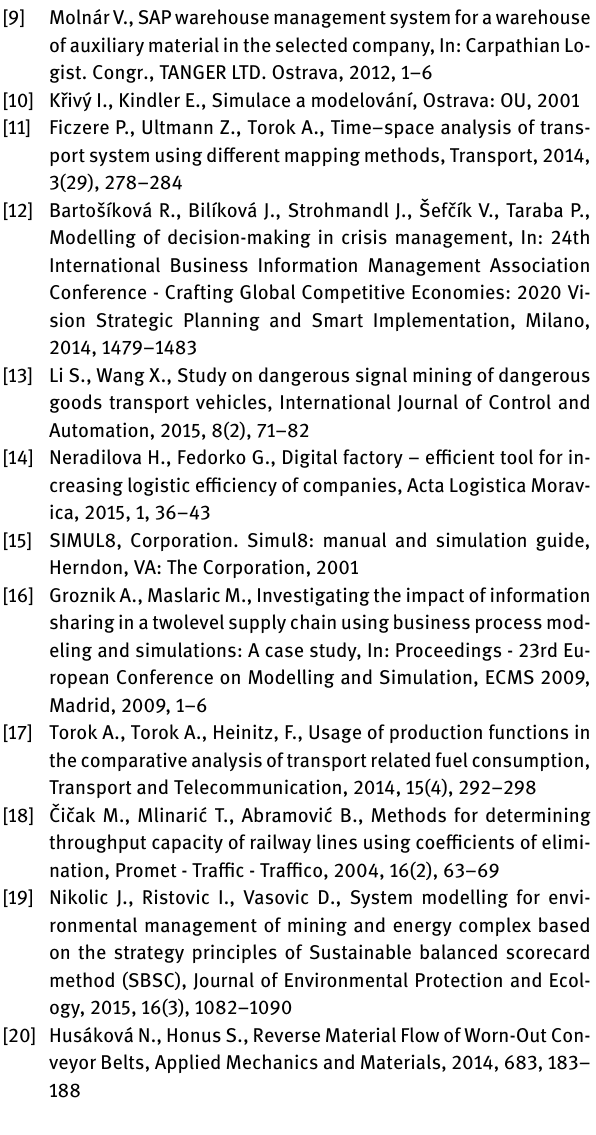
and simulation models for each operation. The paper de- scribes three variants of merging two production plants, describestheassemblysimulationexperiments,execution and evaluation of the different options according to the simulation results. Simulation models has been used in solving the specific logistical problem - the merging of two manufacturing plants in the real